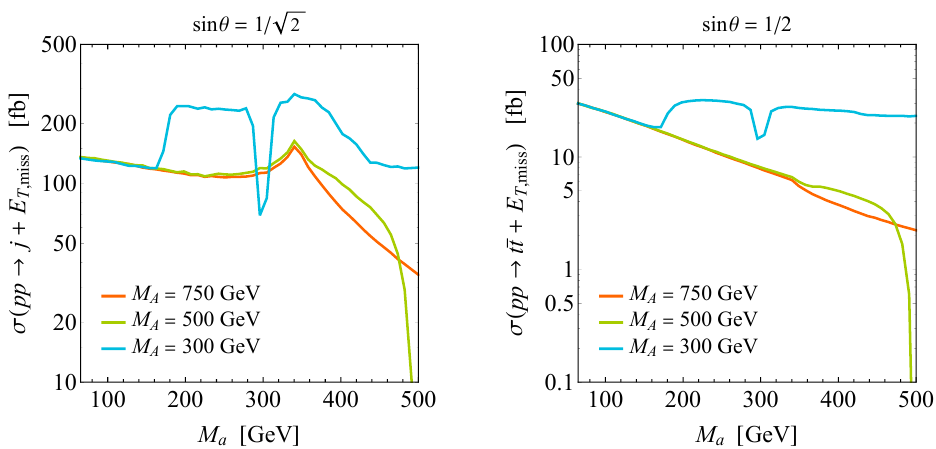
Figure 12 . Predictions for the mono-jet ( t (cid:22) t + E T; miss ) cross section as a function of M a for three p di(cid:11)erent values of M A . In the left (right) plot sin (cid:18) = 1 = 2 (sin (cid:18) = 1 = 2) is used and the other relevant parameters are tan (cid:12) = 1, M H = M H (cid:6) = 750 GeV, (cid:21) 3 = (cid:21) P 1 = (cid:21) P 2 = 0, y (cid:31) = 1 and m (cid:31) = 1 GeV. The shown results correspond to 13 TeV pp collisions and employ minimal sets of cuts as explained in the main